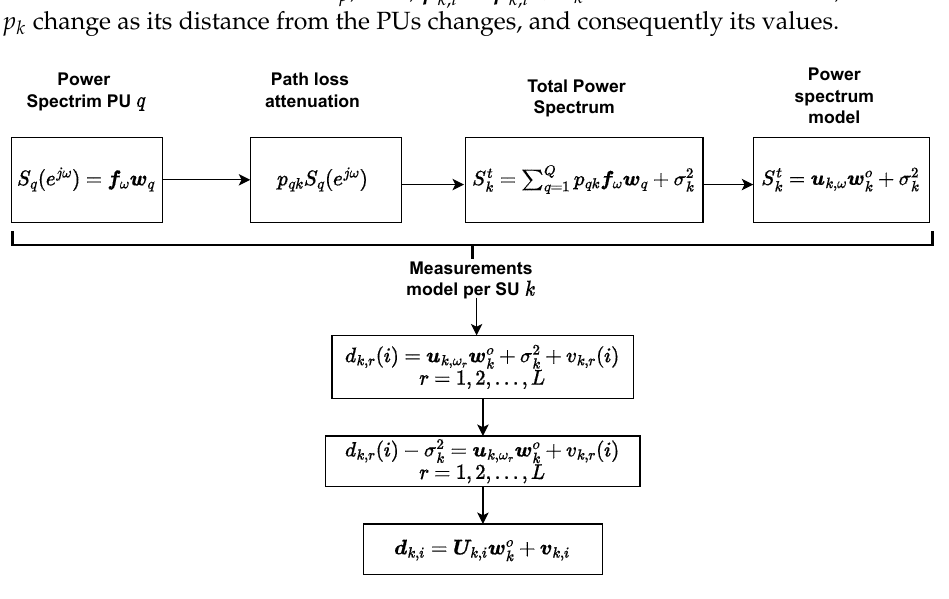
Figure 1. Processing steps involved in the system